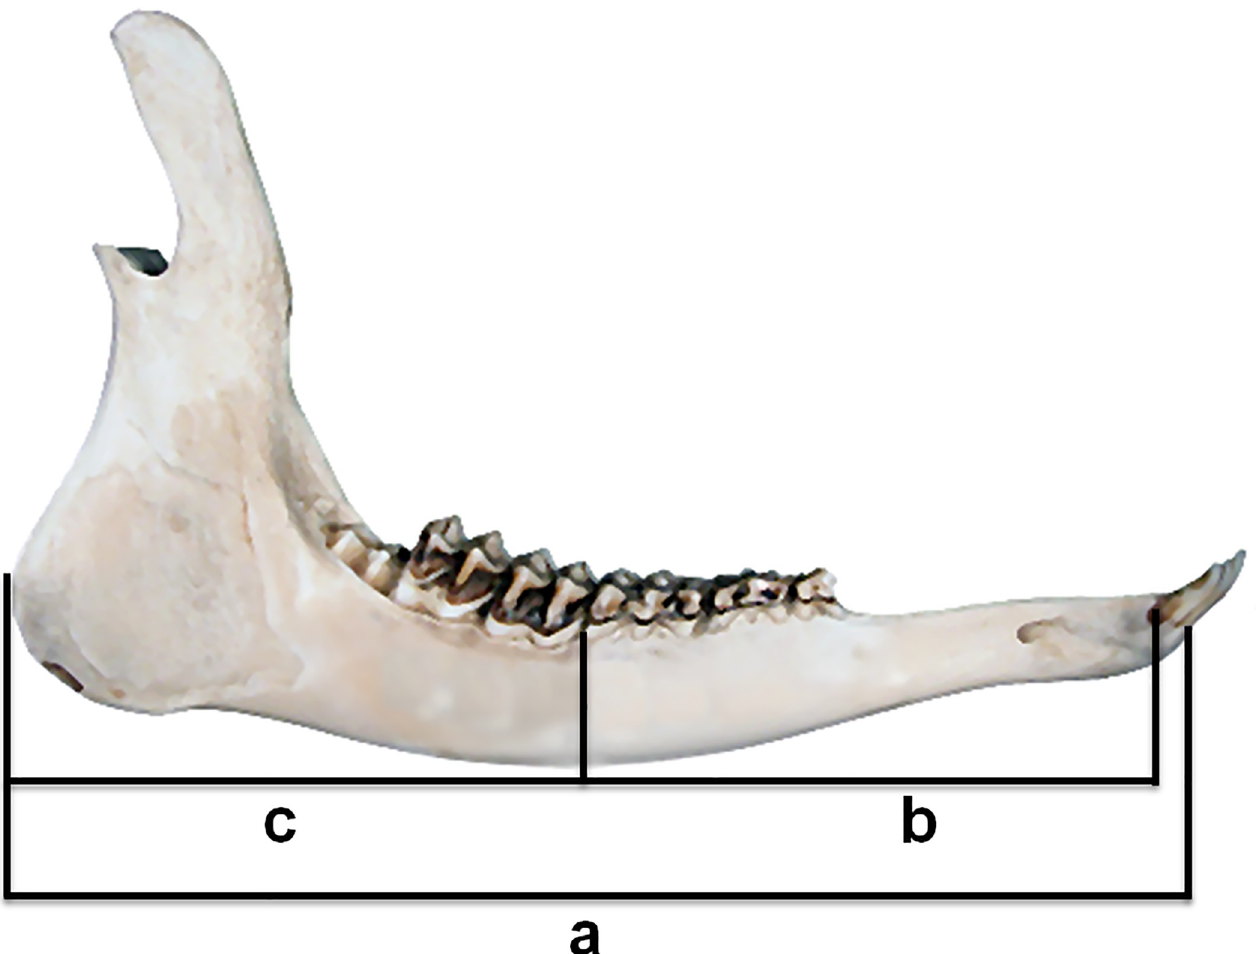
Fig 1. Measurements on roe deer mandible. a: total length measured from the anterior margin of the alveolus of I 1 to the posterior margin of the processus angularis ; b: length of the anterior section measured from the posterior margin of the alveolus of C to the posterior margin of the alveolus of P 4 ; c: length of the posterior section measured from the posterior margin of the alveolus of P 4 to the posterior margin of the processus angularis .